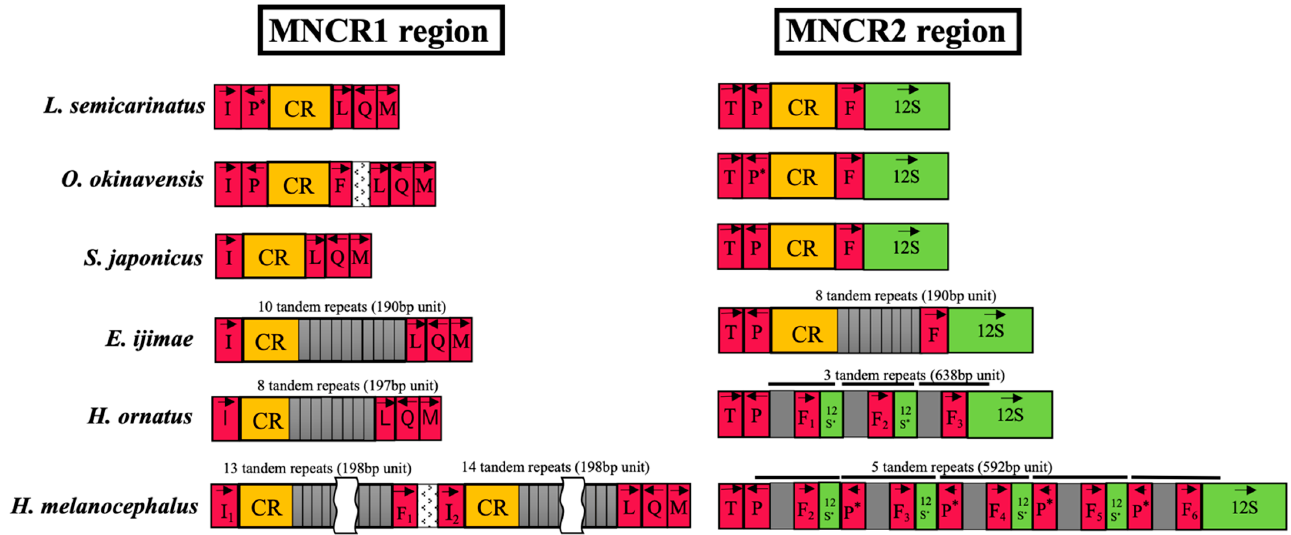
Figure 3. Comparison of features in MNCR1 and MNCR2 regions between several snakes: the colubrid Lycodon semicarinatus [12], the viperid Ovophis okinavensis [14], and four elapid snakes sequenced in this study. Abbreviations of genes and noncoding features are similar to those in Figures 1 and 2, except that directions of encoded genes are shown by an arrow. CR stands for the control region and 12S* represents the 5’-end partial sequence for the 12S rRNA gene. When there are multiple copies for the tRNA Phe and tRNA Ile genes including potential pseudogenes, they are discriminated by the numbering.